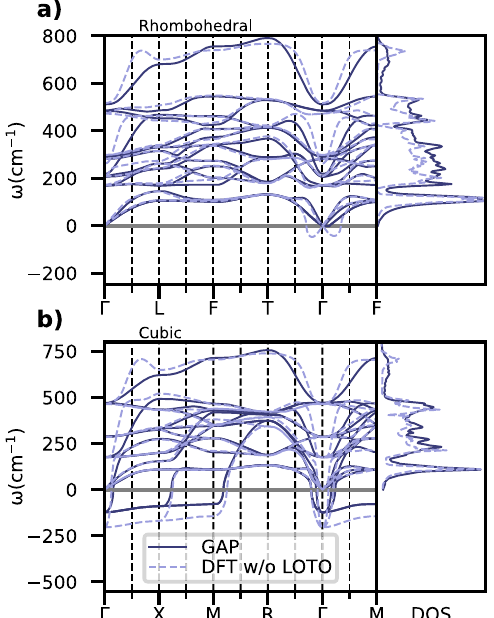
Fig. 12 Phonon dispersion and density of states (DOS) of the stable ( ω > 0) phonons for BaTiO 3 calculated using fi nite differ- ences with a 4 × 4 × 4 q -mesh for. a The 5-atom rhombohedral ground state and b the 5-atom cubic structure (high-symmetry k -point labels from ref. 146 ). We compare the GAP predictions with the DFT calculations without long-range electrostatic contributions, i.e., without LO-TO splitting. The vertical dashed lines indicate the explicitly calculated q